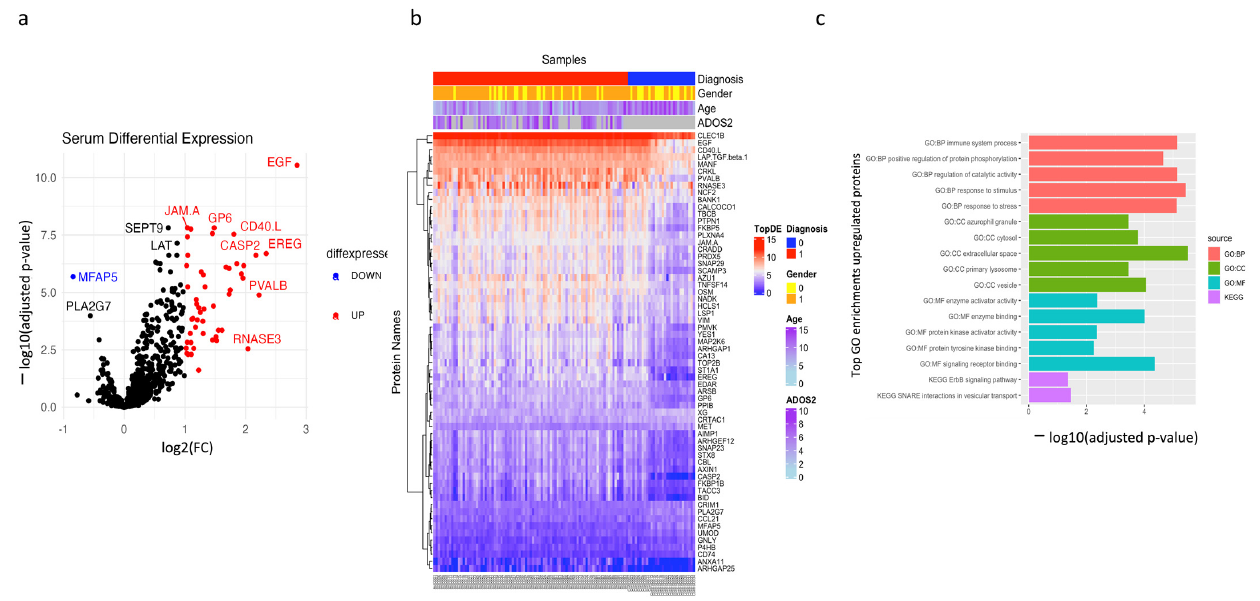
Figure 2. Differential expression of ASD blood proteome. ( a ) The volcano plot shows log2 fold change ( x -axis) against Limma − log10 adjusted p -value ( y -axis) for all the proteins expressed between HCs and ASD cases. Top upregulated and downregulated proteins with an FC > 2 are labeled in red and blue, respectively. ( b ) Supervised heatmap of ASD cases and HCs using the top differentially expressed proteins (TopDE, n = 54), gender (male = 1, female = 0), and diagnosis (ASD = 1, HCs = 0). ( c ) Top GO terms of the upregulated proteins, from TopDE list.